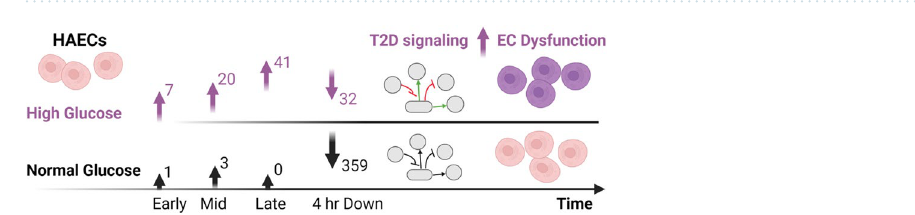
Figure 6. Temporally correlated clusters of DEGs in K-means clusters show differential pathway activation/ inhibition in HG compared to NG conditions. ( A ) Signalling pathways obtained from enrichment analysis using IPA of the ‘late’ DEGs cluster determined from the pairwise comparison of 0 h vs 4 h NG/HG. ( B ) Signalling pathways obtained from enrichment analysis using IPA of the ‘4 h downregulated’ DEGs cluster determined at the pairwise comparison of 1 h vs 4 h NG/HG. A right-tailed Fisher’s Exact test was used to measure significance of the pathway enrichment in the gene sets. The horizontal bars show the level of significance (−log10 p-value). The colour coding of bars indicates activation/inhibition determined by the z-score (generated using fold change and curated pathway relationships from the Ingenuity Knowledge Base), > or < 2 respectively. Hashed bars show significant z-scores. Signalling pathways of interest are highlighted by colour coded boxes.